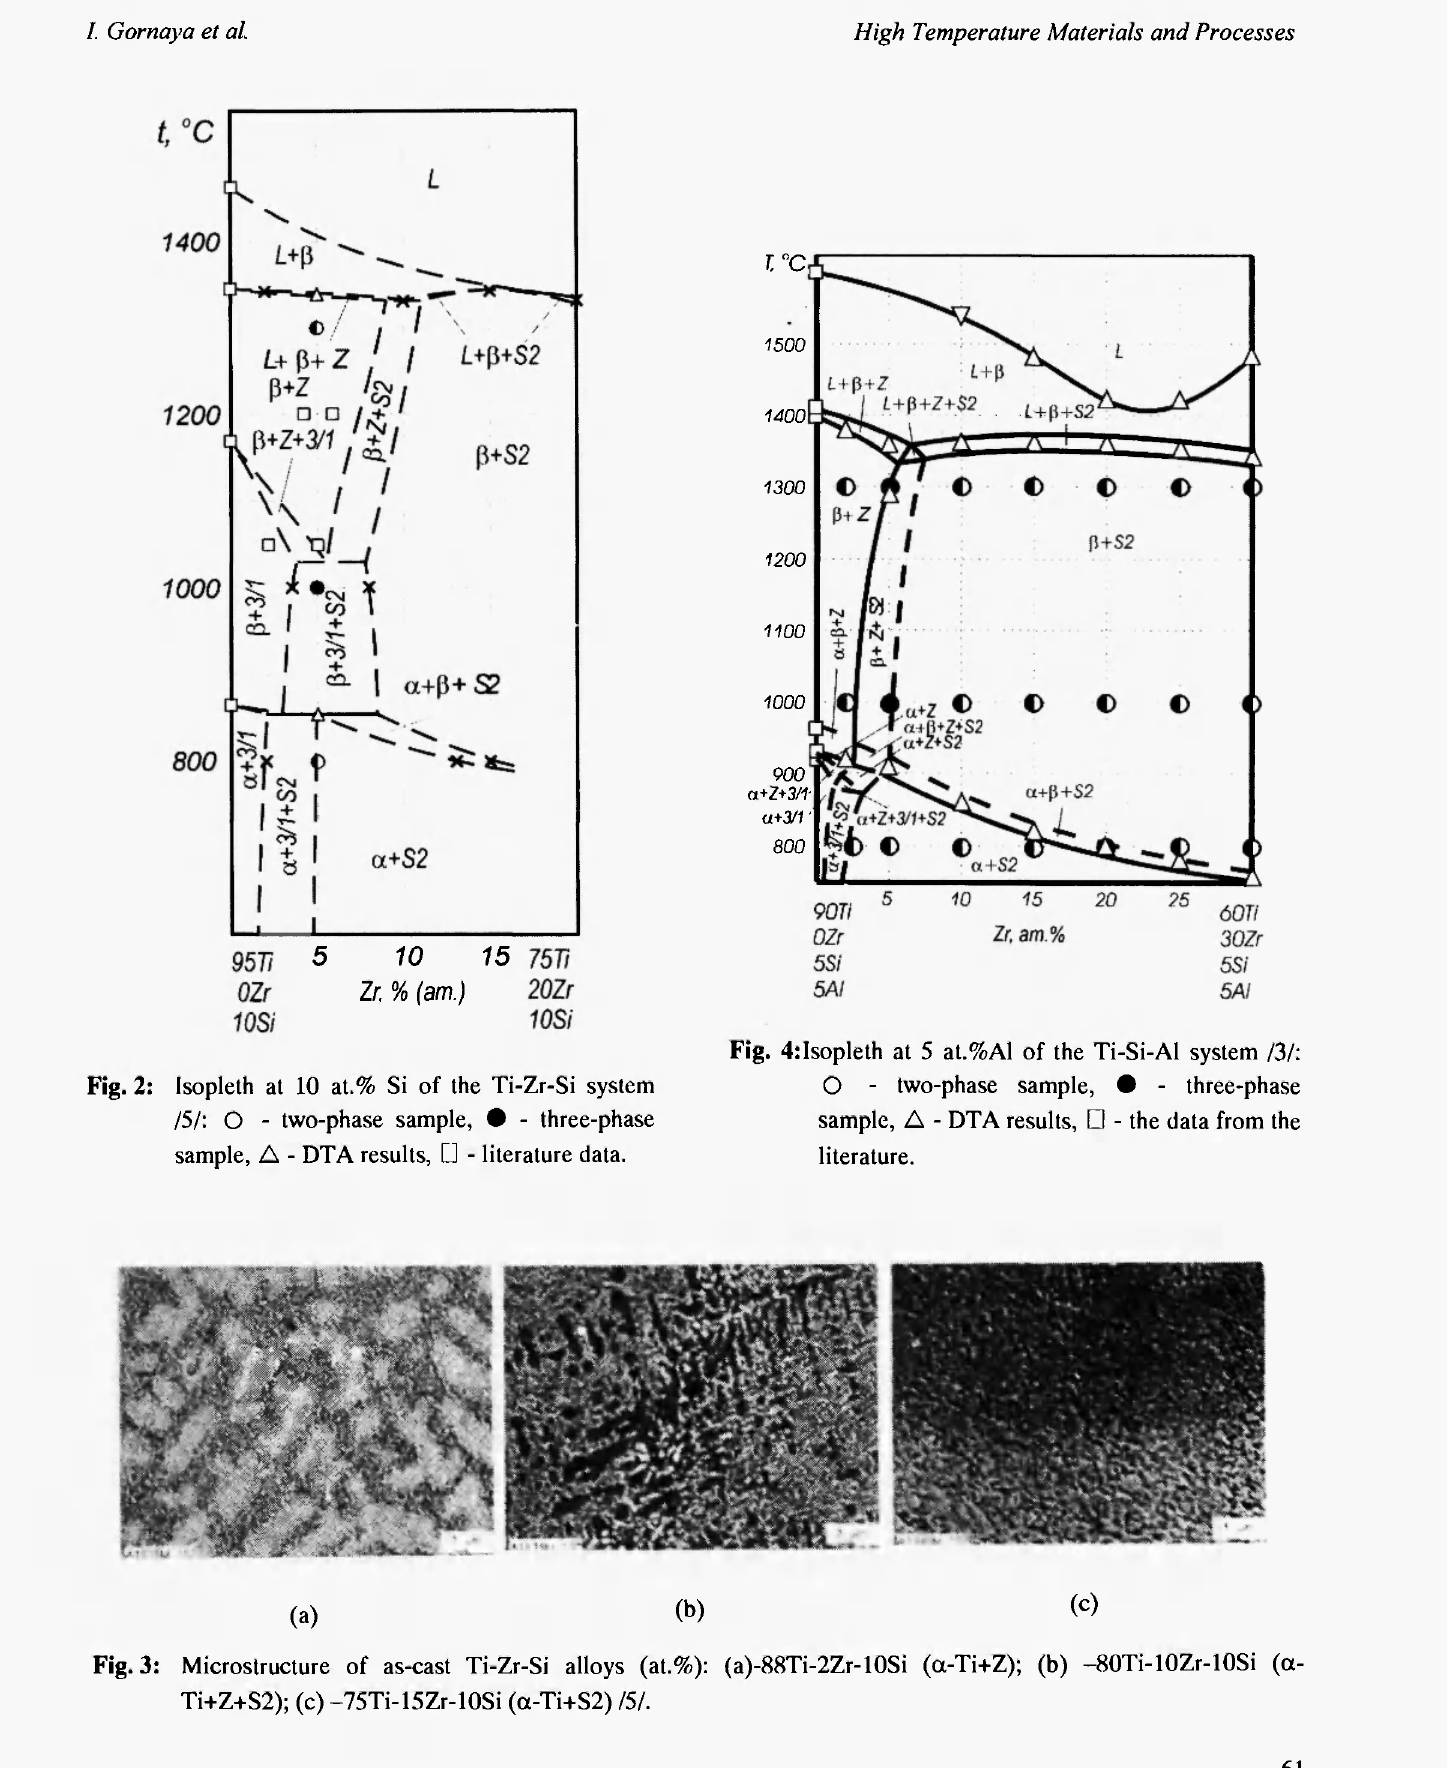
Fig. 3: Microstructure of as-cast Ti-Zr-Si alloys (at.%): (a)-88Ti-2Zr-10Si (α-Ti+Z); (b) -80Ti-10Zr-10Si (a- Ti+Z+S2); (c) -75Ti-15Zr-10Si (a-Ti+S2)